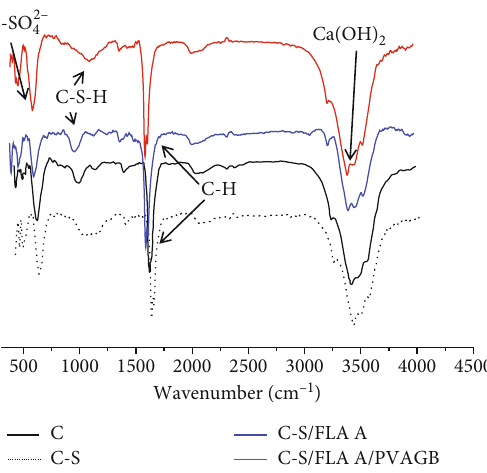
Figure 6: (2) Data contrast for compressive-strength test 1. Samples contain FLA A of di ff erent content and 0.75%BWOC dispersant SXY-2. Sample 1#: FLA A 0.5%BWOC; sample 2#: FLA A 0.7%BWOC; sample 1 ∗ : FLA A 1%BWOC; sample 2 ∗ : FLA A